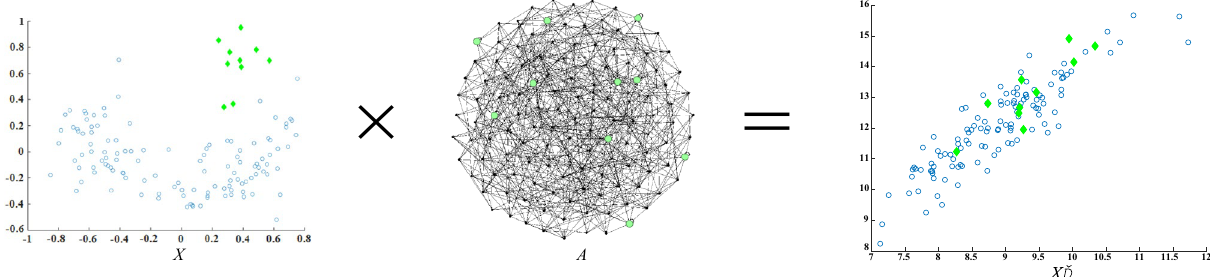
Figure 5. An illustrate graph of feature values propagation. The rightmost side of Fig. 4 shows the distribution of X after feature value propagation. When the object aggregates the feature values of other objects, its own feature values change, resulting in a significant change in the overall data